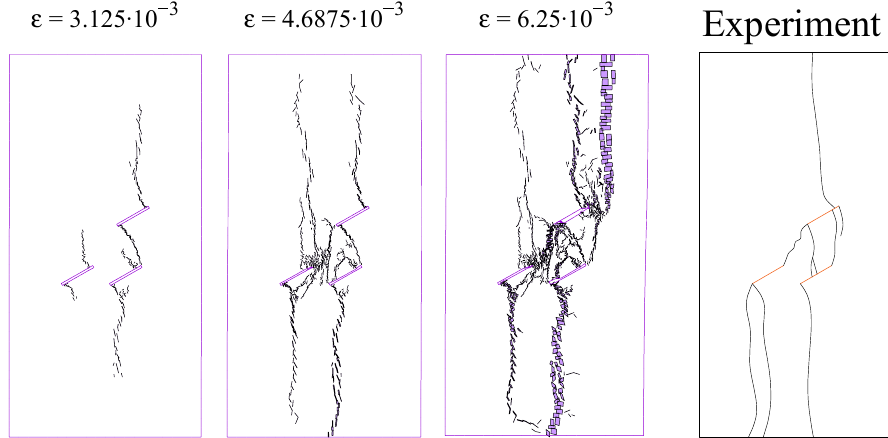
Figure 10. Sandstone containing three pre-existing fissures (Case 4): the crack opening plots (deformation scale 1:1) compared to the experimental results provided in